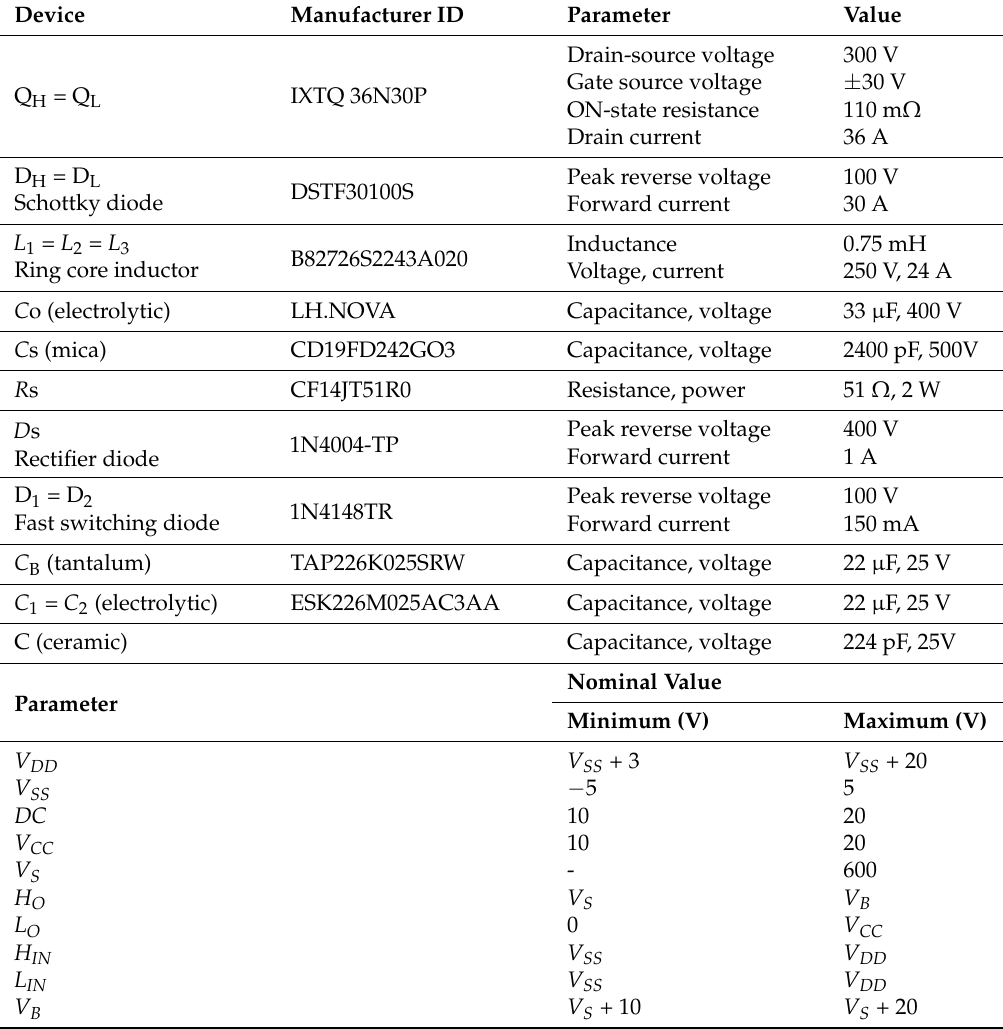
Table 3. List of parameters and their specifications used for the implementation of the multiple input